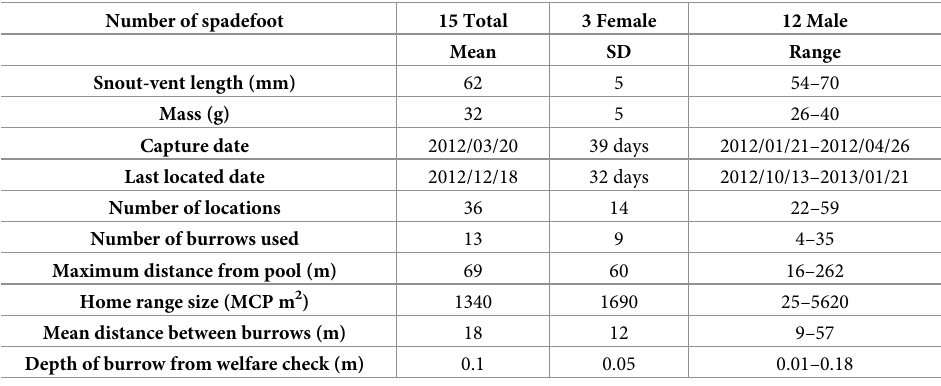
Table 1. Summary of spadefoot characteristics and